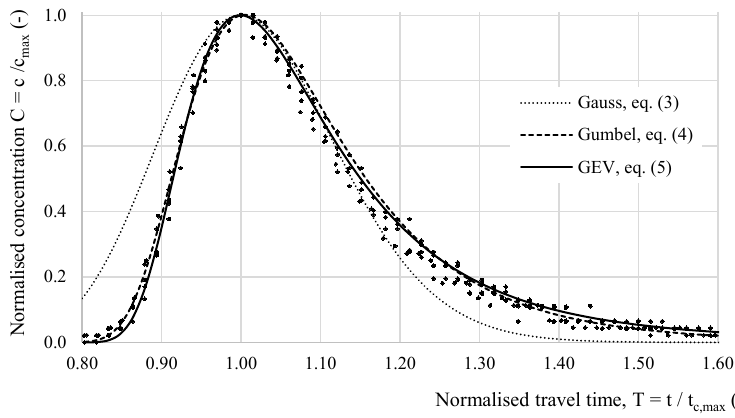
Figure 3. Example of a raw and averaged (approximated) data (experiment Nr. 2.4).